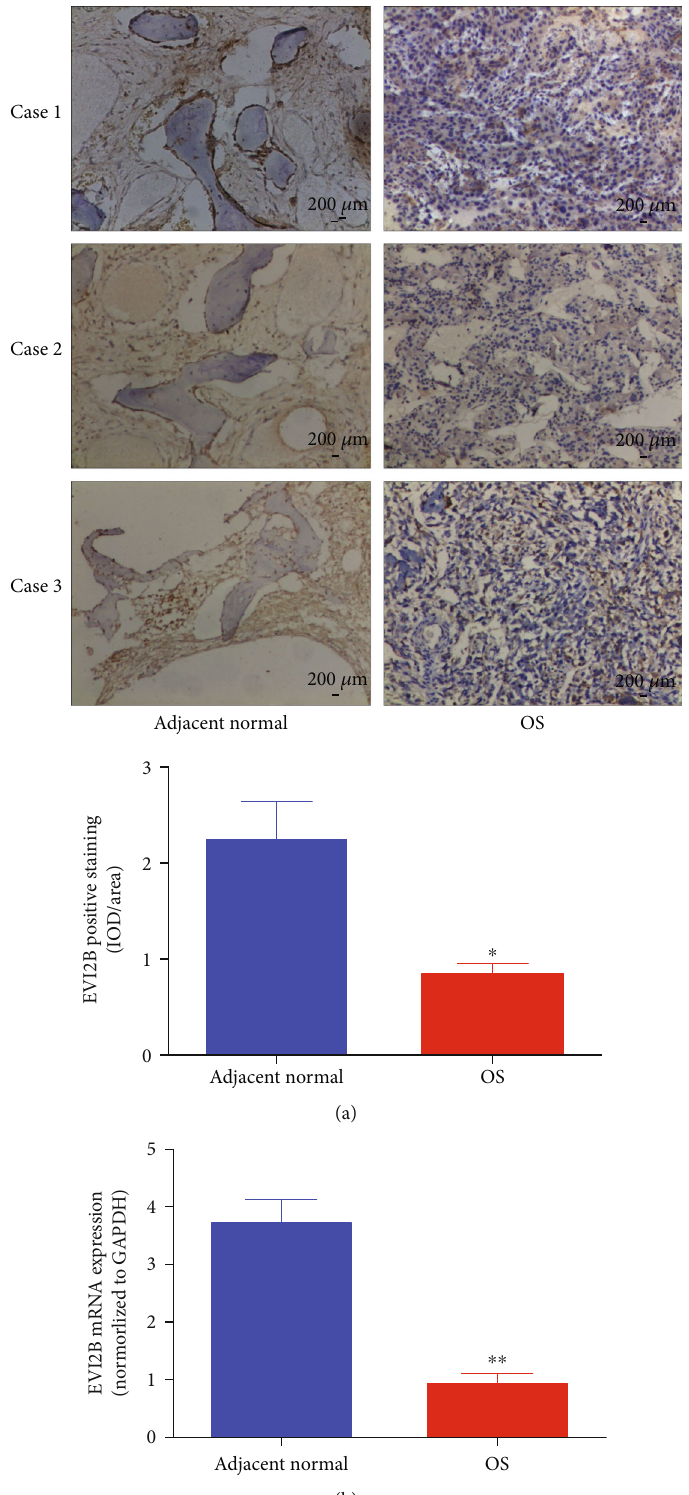
Figure 7: The relative EVI2B expression in OS tissues and adjacent normal tissues. (a) The immunohistochemical detection results showed the expression level of EVI2B in osteosarcoma tissues and adjacent normal tissues. (b) RT-qPCR analysis of relative EVI2B expression in OS tissues and adjacent normal